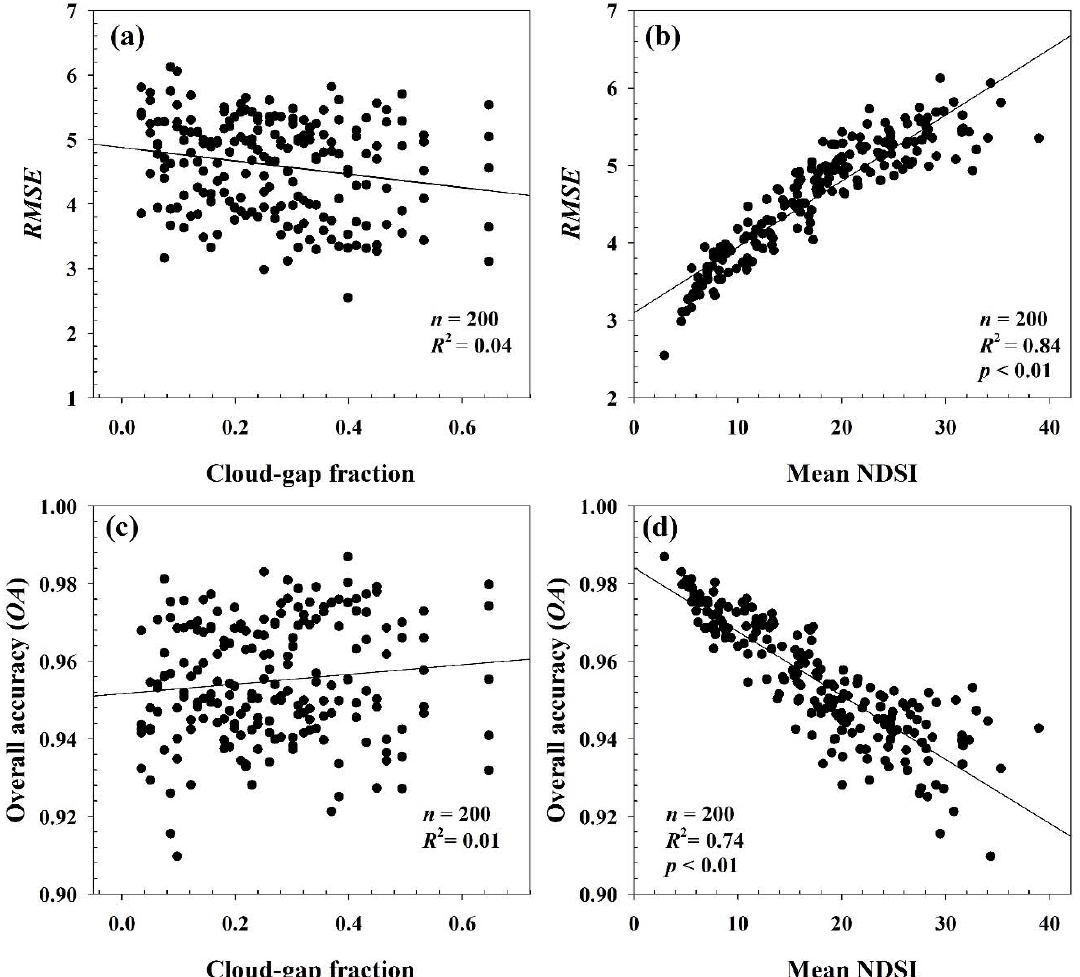
Figure 17. Relationships between the accuracy indexes: ( a ) RMSE and the cloud-gap fraction, ( b ) RMSE and the mean NDSI, ( c ) overall accuracy ( OA ) and the cloud-gap fraction, and ( d ) OA and the mean NDSI.